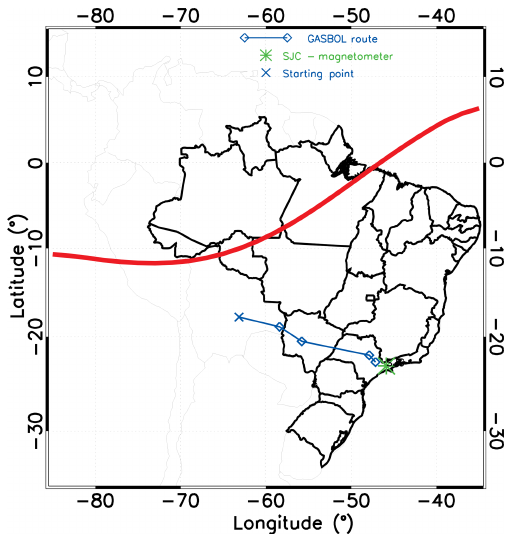
Figure 1. Bolivia–Brazil gas pipeline route (solid line), bends (di- amonds), and São José dos Campos (23.2 ◦ S, 45.9 ◦ W) magnetic observatory (star). The red line represents the geomagnetic equa- tor. The route length is 1814km. The pipeline route runs through 557km to the Brazilian border. The pipeline starts in Bolivia and is represented by “ ×